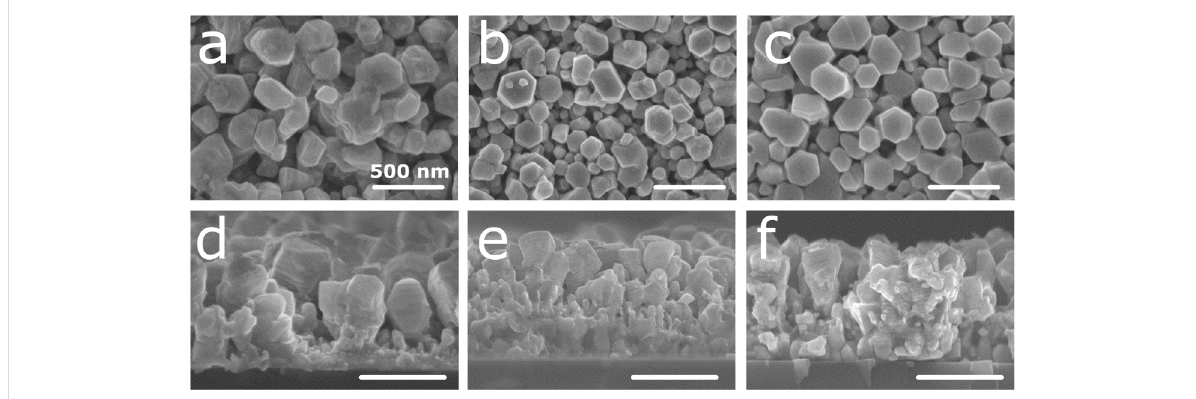
Figure 1: (a–c) Plan view and (d–f) cross-section SEM images of the Ag–Al alloy thin film with an initial composition of (a and d) 18, (b and e) 30, and (c and f) 36 atom % of Ag.